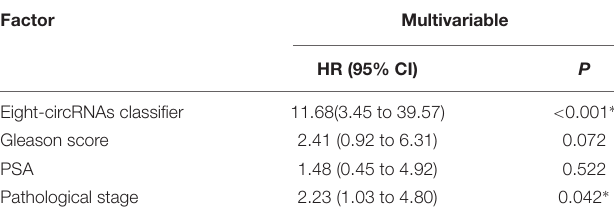
TABLE 3 | Cox proportional hazards models in 144